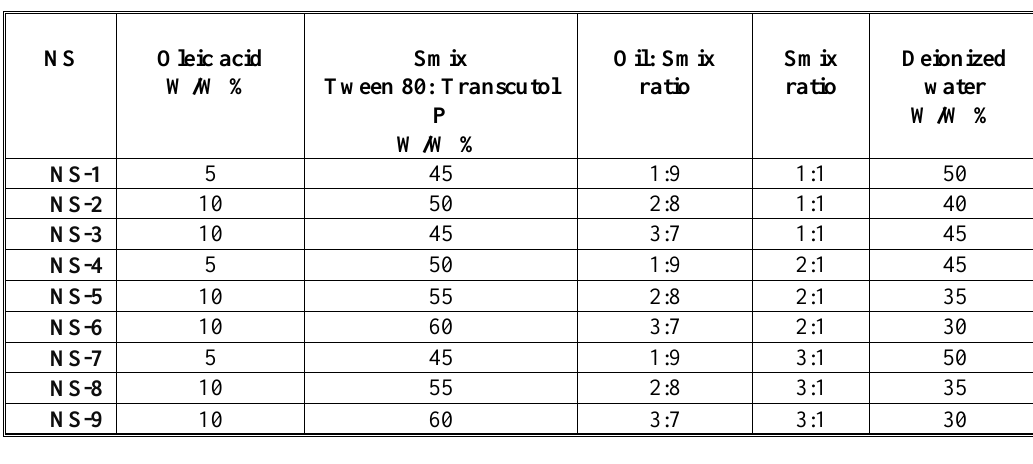
Table 1 . Composition of LZL loaded nanoemulsion